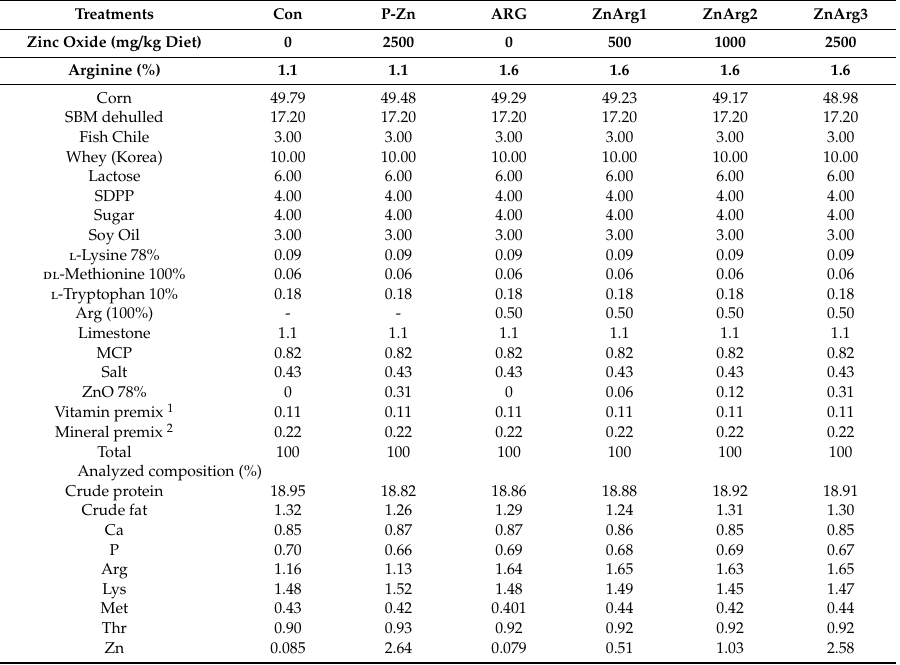
Table 1. Formula and chemical composition of basal diets (as-fed basis). Treatments Con P-Zn ARG Zinc Oxide (mg / kg